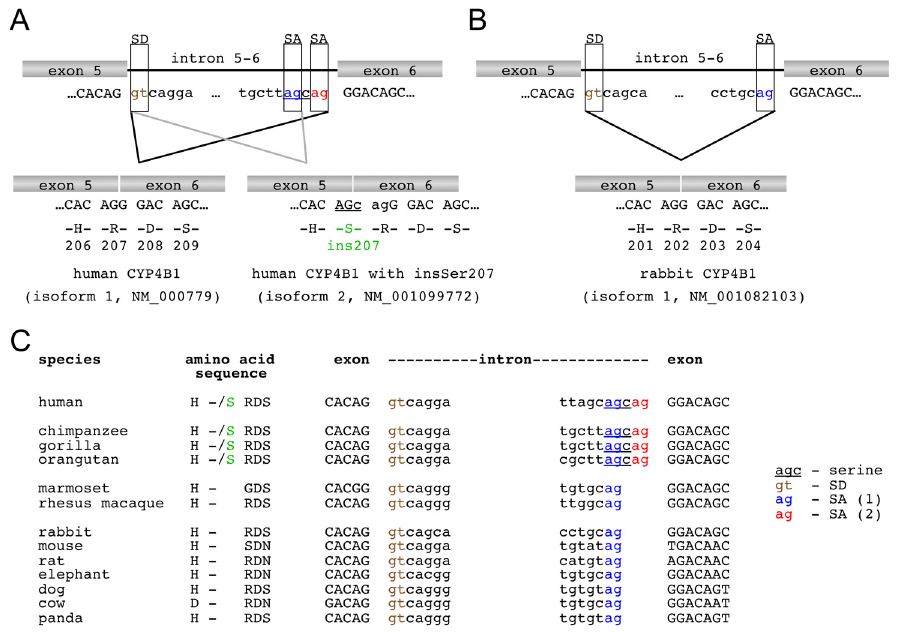
Fig 1. Alternative Splicing of CYP4B1 . (A) Human CYP4B1 . The human CYP4B1 intron 5 – 6 harbors two splice acceptors (SAs) in frame allowing the generation of two alternative CYP4B1 transcripts, with (isoform 2: NM_001099772) or without (isoform 1: NM_000779) insSer207. (B) Rabbit CYP4B1 . Intron 5 – 6 of rabbit CYP4B1 carries only a single SA and therefore generates a single transcript without insSer202 (isoform 1: NM_001082103). (C) Alignment of CYP4B1 sequences from other species. Alignment of the genomic DNA of CYP4B1 from other species shows that the insertion of the CAG triplet, which generates the additional splice acceptor site, exists only in humans and great apes, and not in rhesus, macaque, marmoset or other mammals.